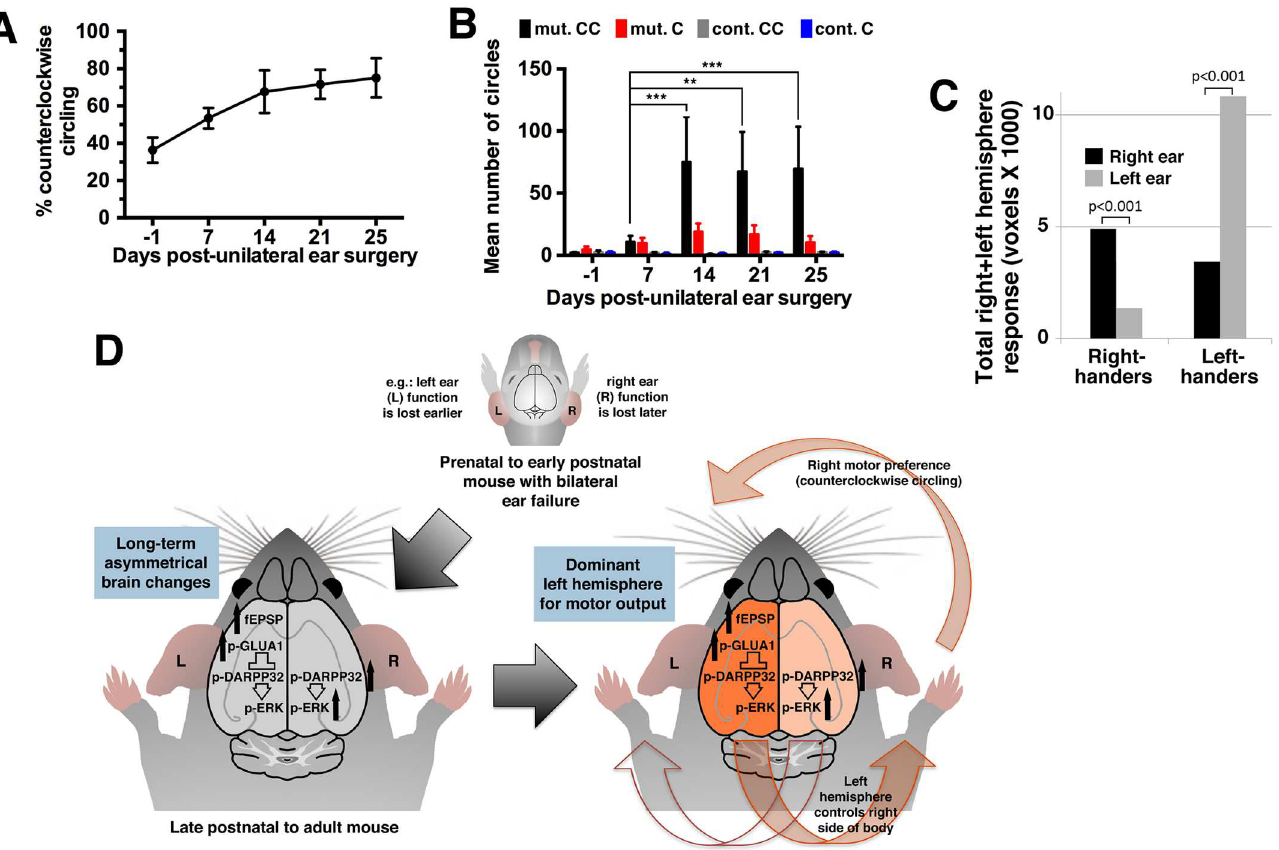
Fig 7. Imbalanced inner ear dysfunction determines the preferred turning direction. (A) Open field recordings of Tbx1 Cre/+ ; Slc12a2 fx/fx mutants ( n = 10) before (day − 1) and after unilateral surgery on the left ear showed a preference for CC turning by 14 days. See also S1 Data. (B) Average CC and C turns for the mutants in panel A and littermate controls ( n = 10) with unilateral ear surgery. Two-way RM ANOVA with Tukey’s multiple comparison test (between mutant CC and C: at day 14, p = 0.0051; day 21, p = 0.0019; day 25, p < 0.0001). See also S1 Data. (C) Activation during caloric vestibular stimulation of the right and left ear in a right- and left-hander with numbers of voxels exhibiting significant differences in effect size between left and right hemispheres (paired t test; n = 12 right-handers, n = 12 left-handers; p < = 0.001). See also S1 Data. (D) Model of ear-induced lateralization. C, clockwise; CC, counterclockwise; fEPSP, field excitatory postsynaptic potential; p-ERK, phosphorylated extracellular signal-regulated kinase; RM, repeated measure.